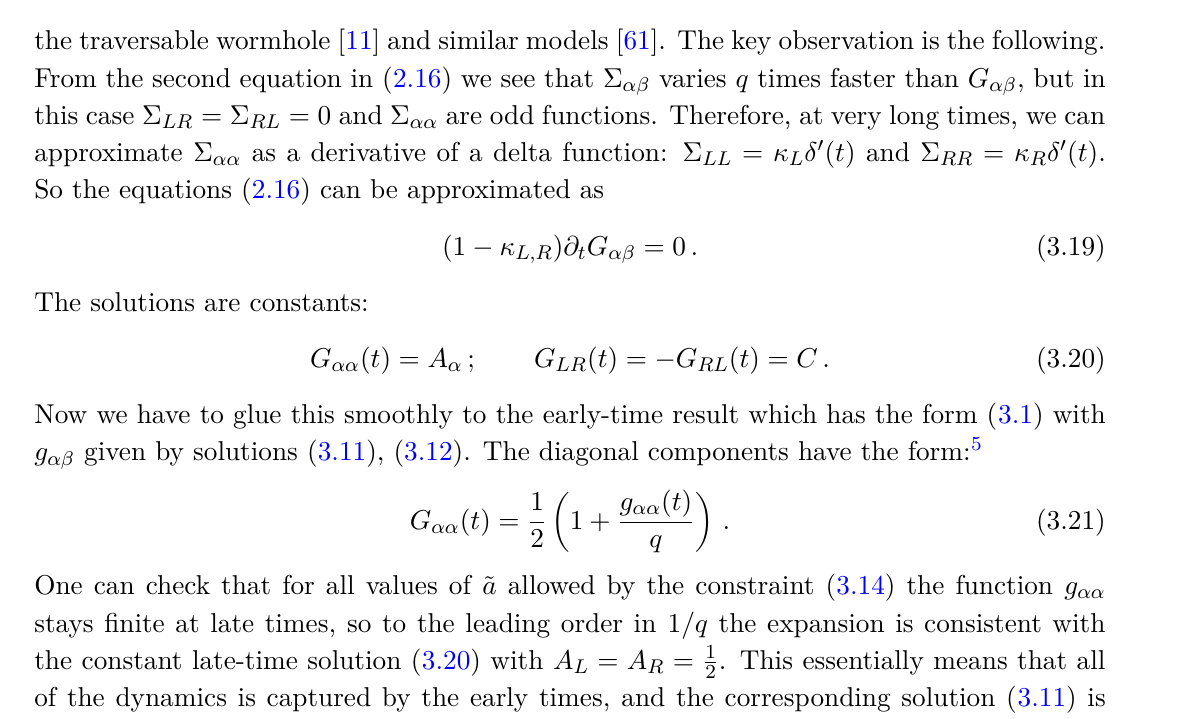
Figure 4 . Locations of solutions of the constraint (3.14) on the complex right half-plane parametrized by J T ∈ [0 , 100] . The trajectories of subleading solutions (shown by orange curves) are not shown completely, but only their late-time tail ends are